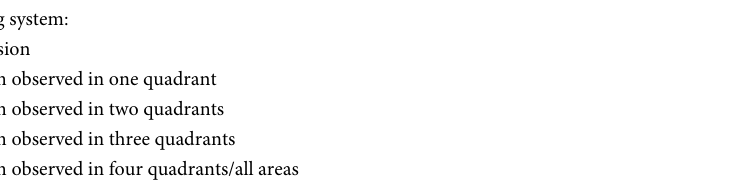
hamsters. Likewise, qPCR also showed positive amplification for all samples (blood, lungs, liver and kidneys) collected from the infected hamsters from day 1 to day 7 p.i. (Fig 6). No cul- tures were performed for the lungs and liver. The leptospiral load (qPCR) in blood and organs showed a progressive increase from day 1 to day 5 p.i. for blood, lungs and kidneys and until and liver while the load remained unchanged in the kidneys. Table 2. Histological scoring in hamsters infected with L . interrogans strain HP358.